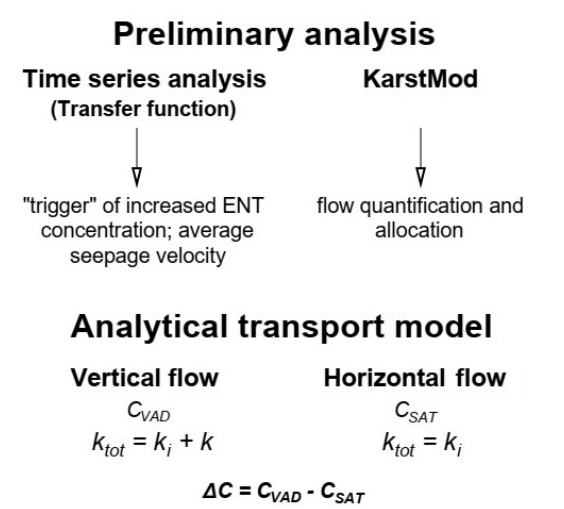
Figure 2. Basic steps of the proposed methodology for determining the die-off coefficient ( k tot —total die-off coefficient, k i —natural die-off coefficient, k —sorption